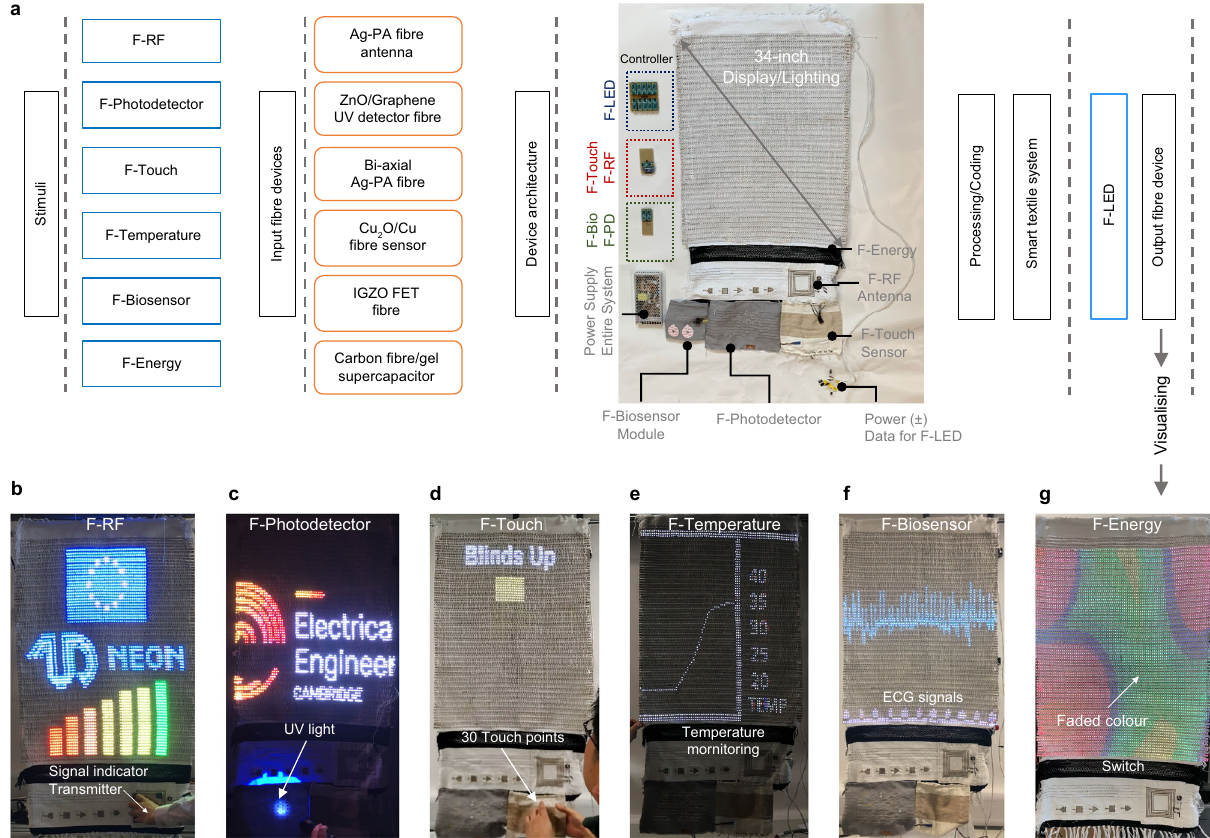
Fig. 4 Design of smart textile display system from material to system level. a List of F-devices integrated into the smart textile system, materials, device architecture, auxiliary parts, signal processing/coding, and F-LED visualising. Applications displaying on textile system: Real-time operation photos of b Six- signal strengths digitized depending on the distance between F-RF antenna and transmitter. c Programmed image initiated by UV irradiation on F-photodetector. d Real-time temperature monitoring by F-temperature sensor grasped by fi ngers. e Electrocardiography signal measured by F-biosensor module. f One of 30 IoT functions operated by F-touch sensor. g F-energy as a power supply to the switch of textile